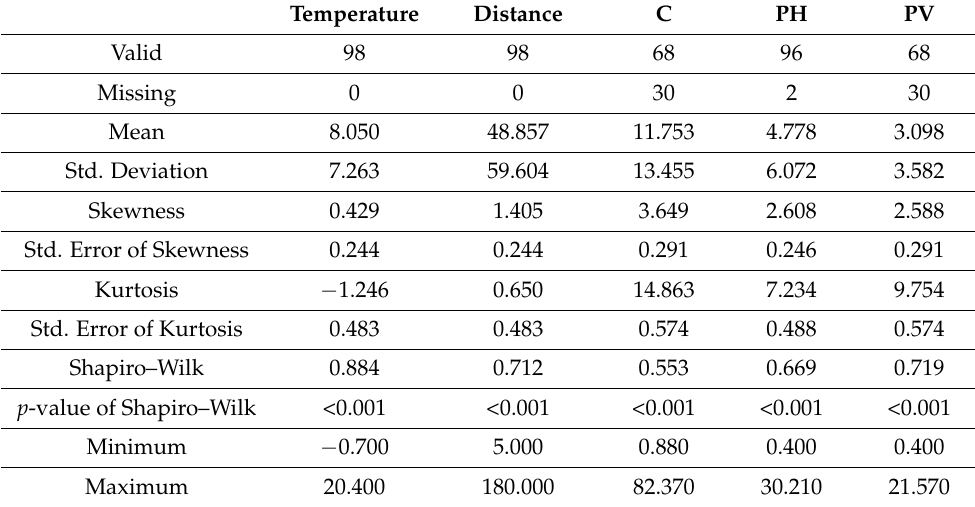
Table 3. Descriptive statistic using JASP.